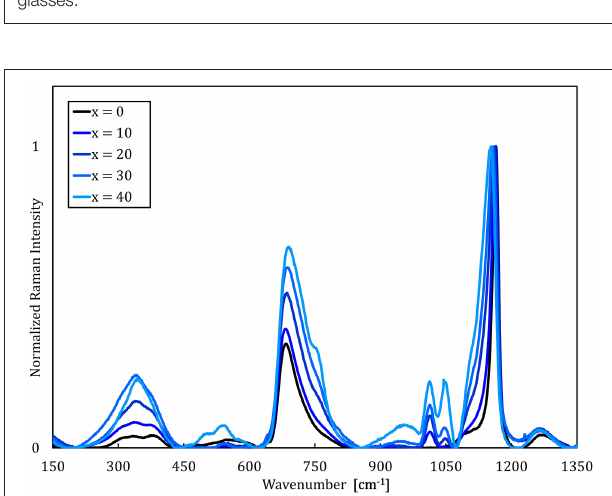
FIGURE 2 | Normalized Raman spectra for the (100–x)NaPO 3 -xNaCl